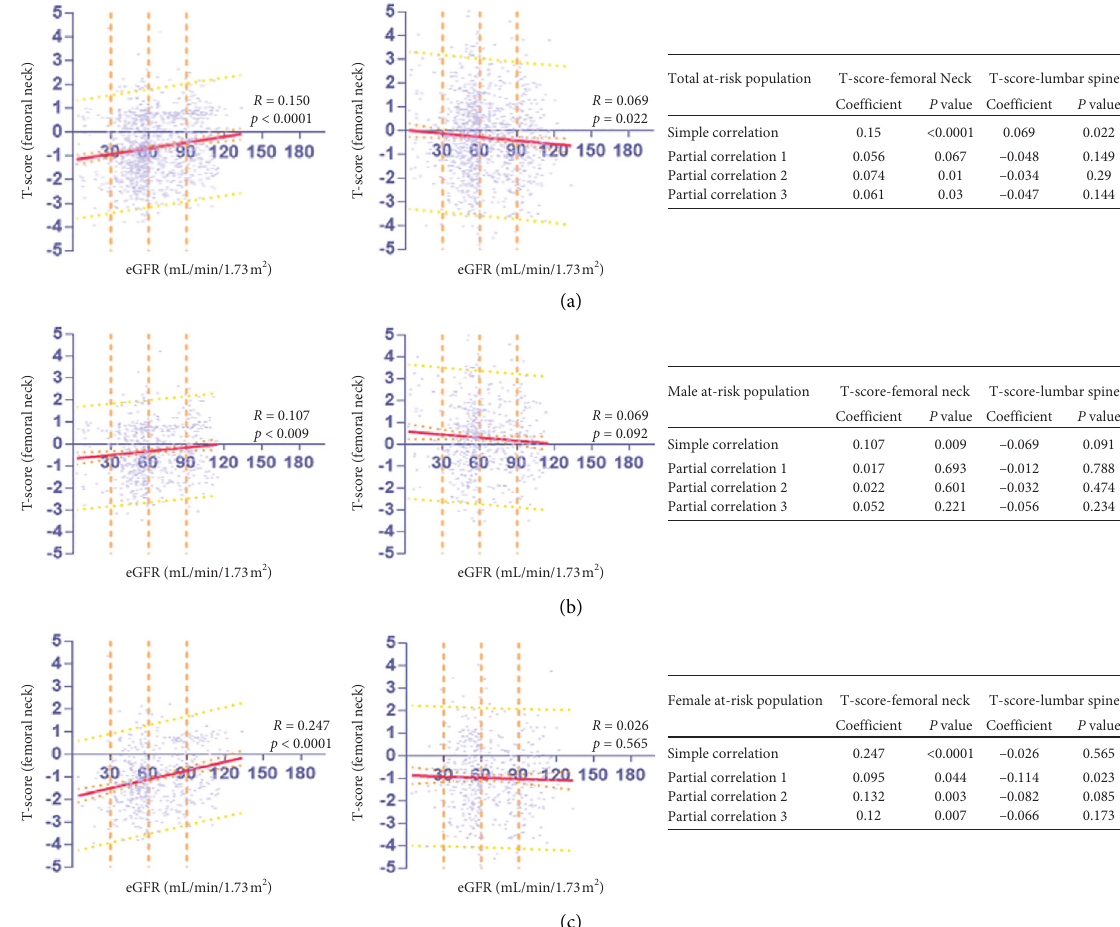
Figure 2: Scatterplot, Pearson correlation, and partial correlations between T-score and eGFR in the total at-risk population, male at-risk population, and female at-risk population (a, b, and c, respectively). T-score is presented by a logarithmic scale along the y -axis and eGFR along the x -axis. Regression lines are shown with 95% CIs (orange lines) and 95% prediction interval (yellow lines). BMD, bone mineral density; eGFR: estimated glomerular filtration rate; the at-risk population, male participants aged ≥ 50 years, and postmenopausal